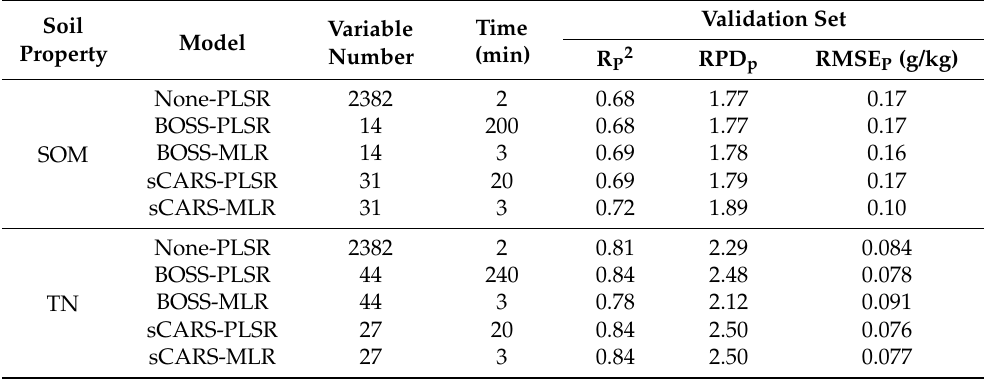
Table 2. Modeling results of SOM and TN screened with different variables selection methods.